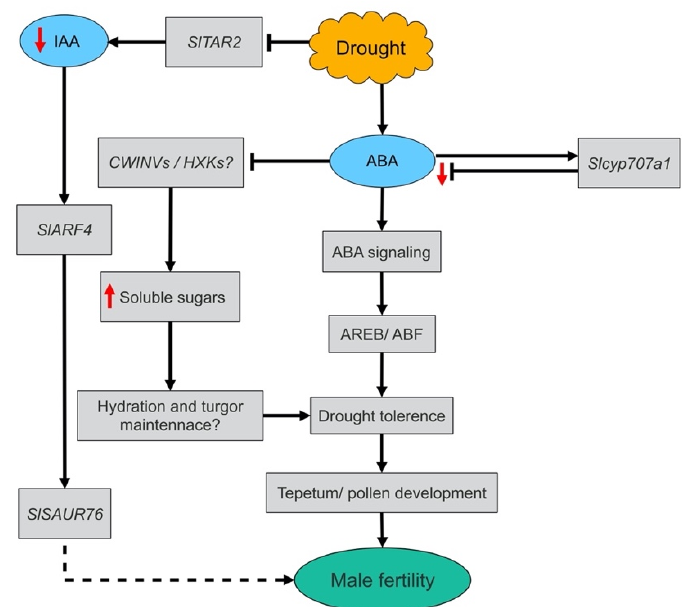
Figure 8. Proposed model of drought tolerance mechanisms in tomato anthers during early stages of development. ABA: abscisic acid; IAA: indole-3-acetic acid; CWINVs: cell wall invertases; HXKs: hexokinases; AREB: abscisic acid-responsive element-binding protein; ABF: abscisic acid- responsive element binding factor; Up-ward pointing red arrow: significant increase; Down-ward pointing red arrows: significant decrease; Dash line: suggested to play a role, early in anther/pol- len development since SlAUR76 ( ID: Solyco8g077020.1 ) was significantly repressed in our tran- scriptome but has not been functionally proven.